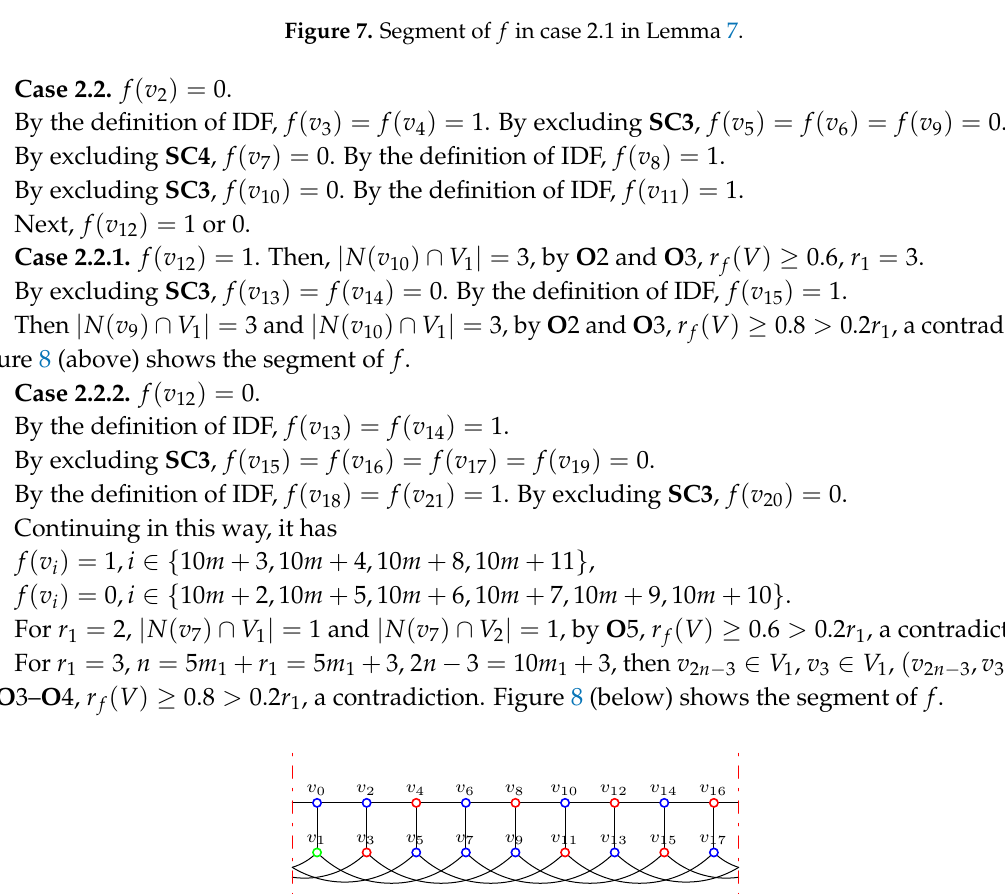
Figure 7. Segment of f in Case 2.1 in Lemma 7.